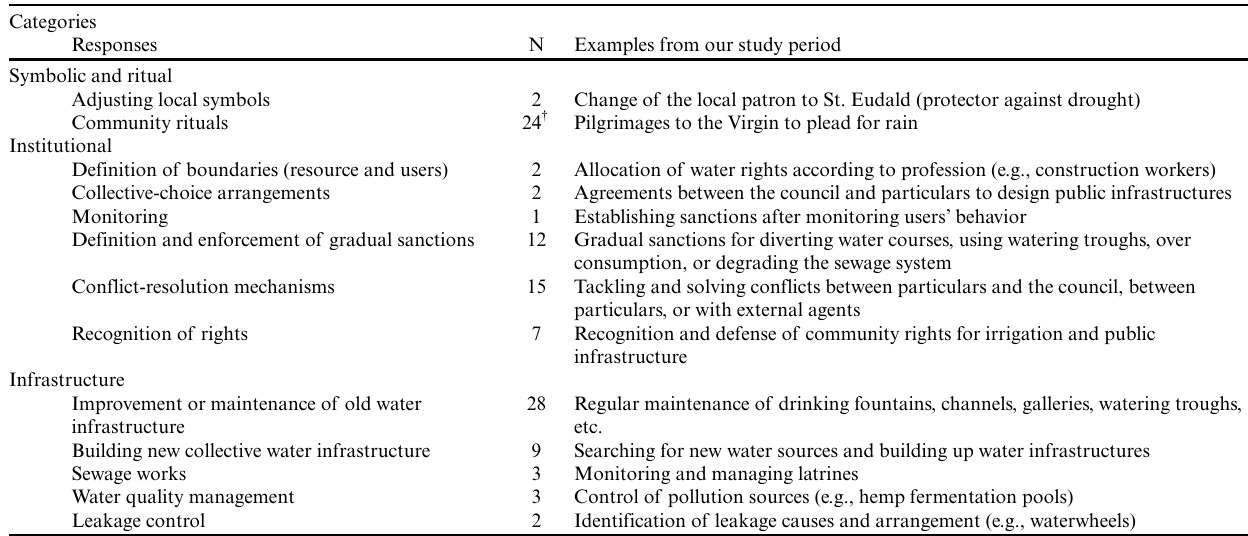
Table 1 . Responses to droughts in the village community of Terrassa (Barcelona), as reported by documentary sources (1605-1710). N refers to the total number of decisions.